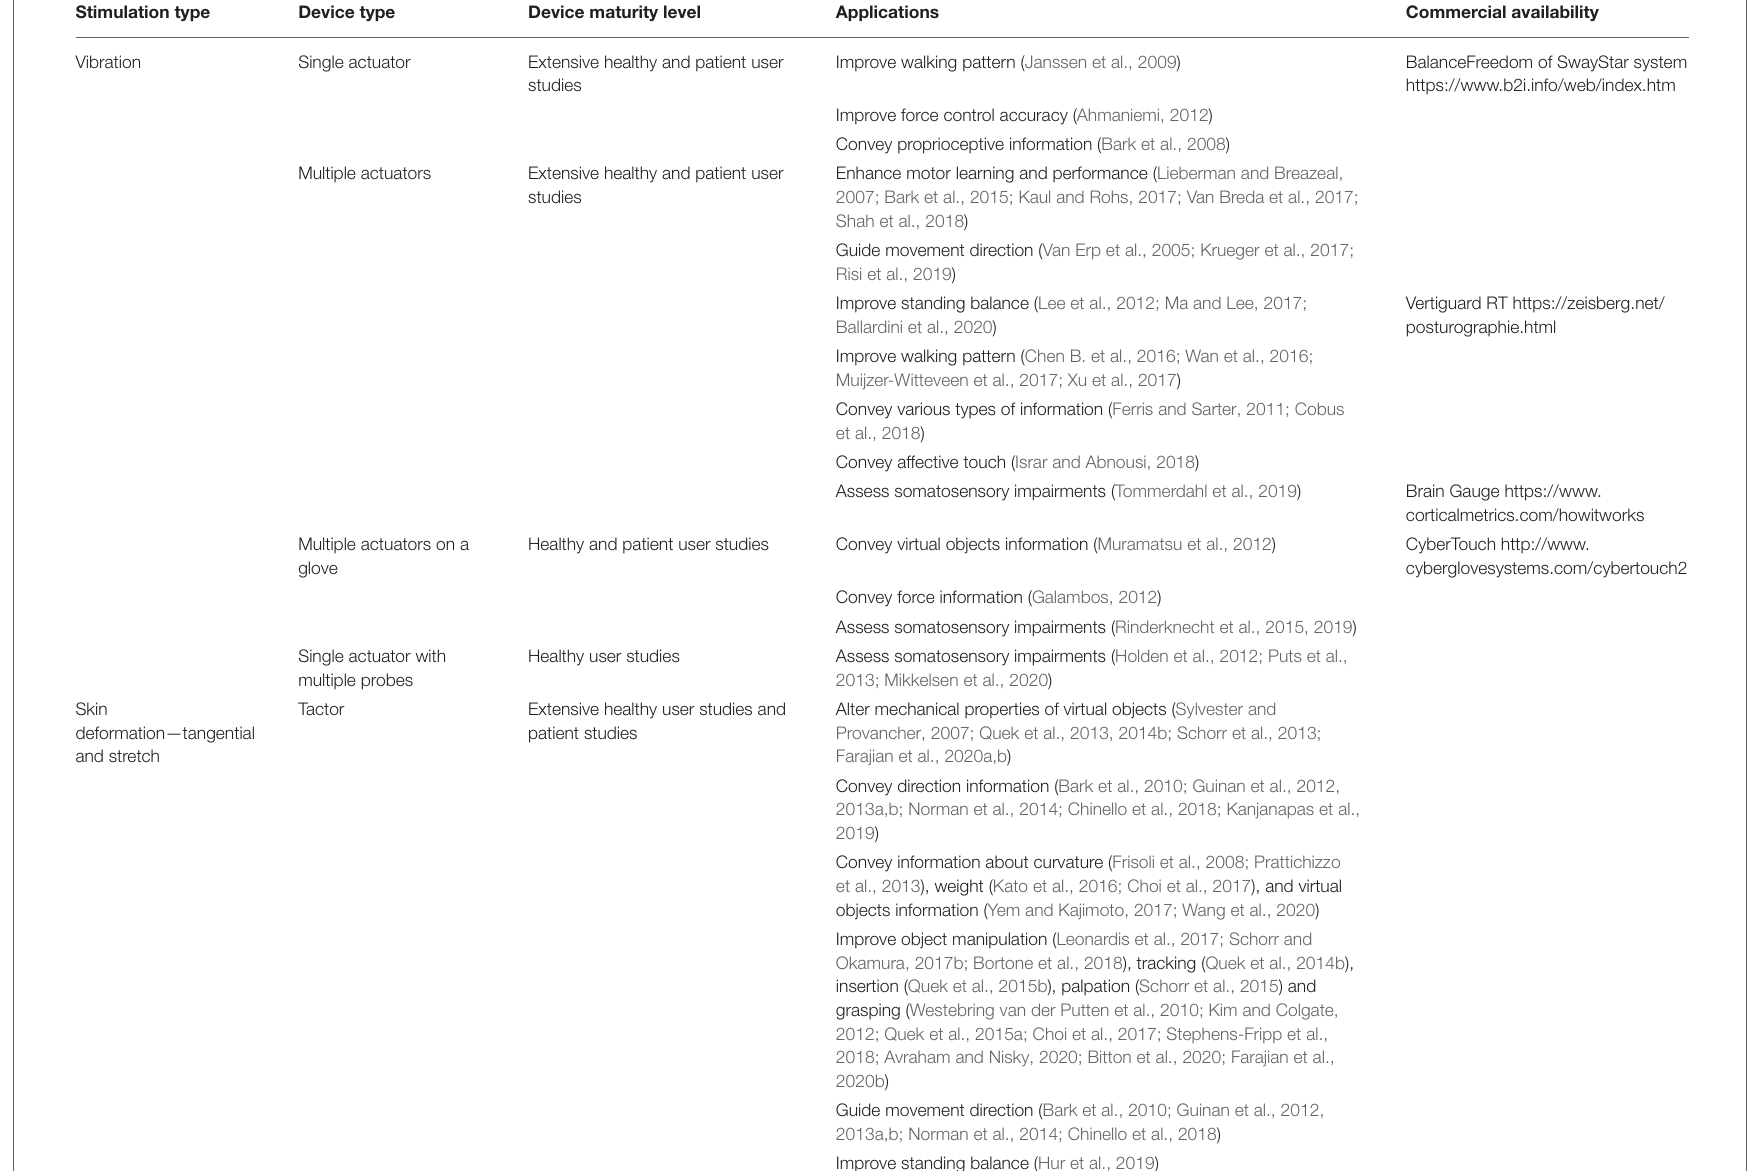
TABLE 1 | Tactile stimulation devices by type, maturity level, and applications in healthy